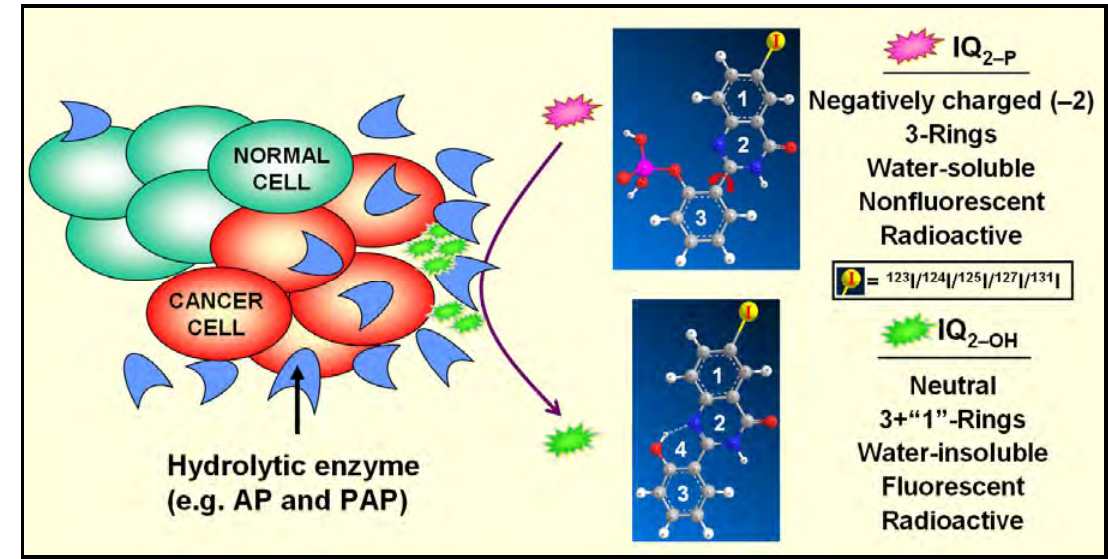
Figure 1. Schematic diagram of EMCIT